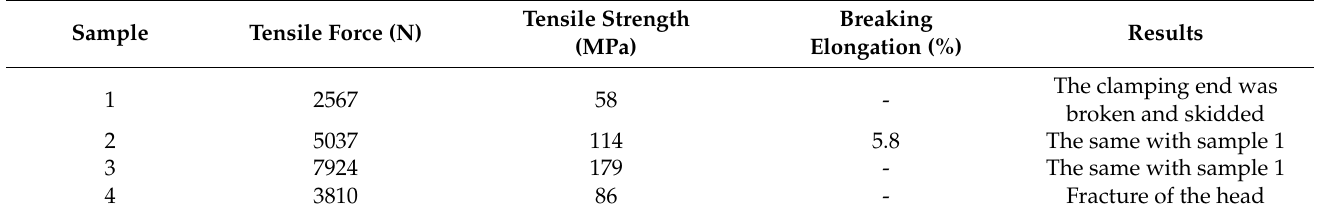
Figure 1. Sample of tensile test. ( a ) Single BFR; ( b ) BFR mesh. Table 1. Tensile strength of single BFR. Table 1. Tensile strength of single BFR.